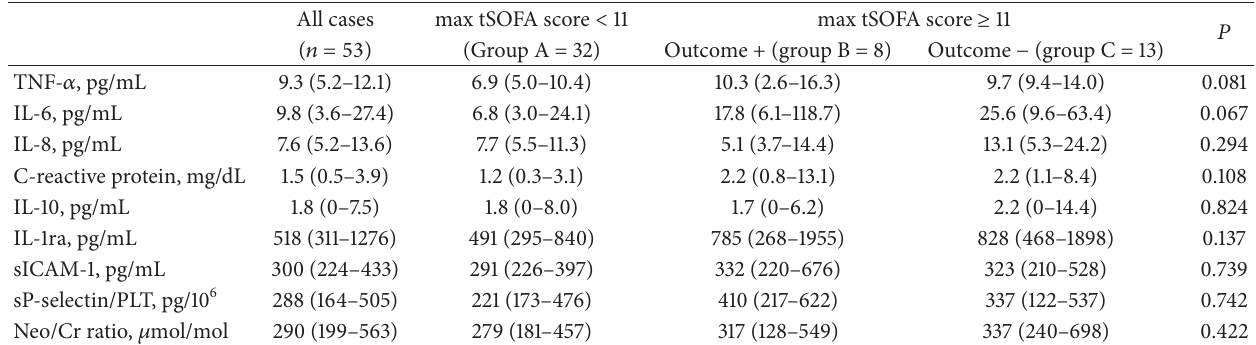
Table 2: Preimplant inflammatory